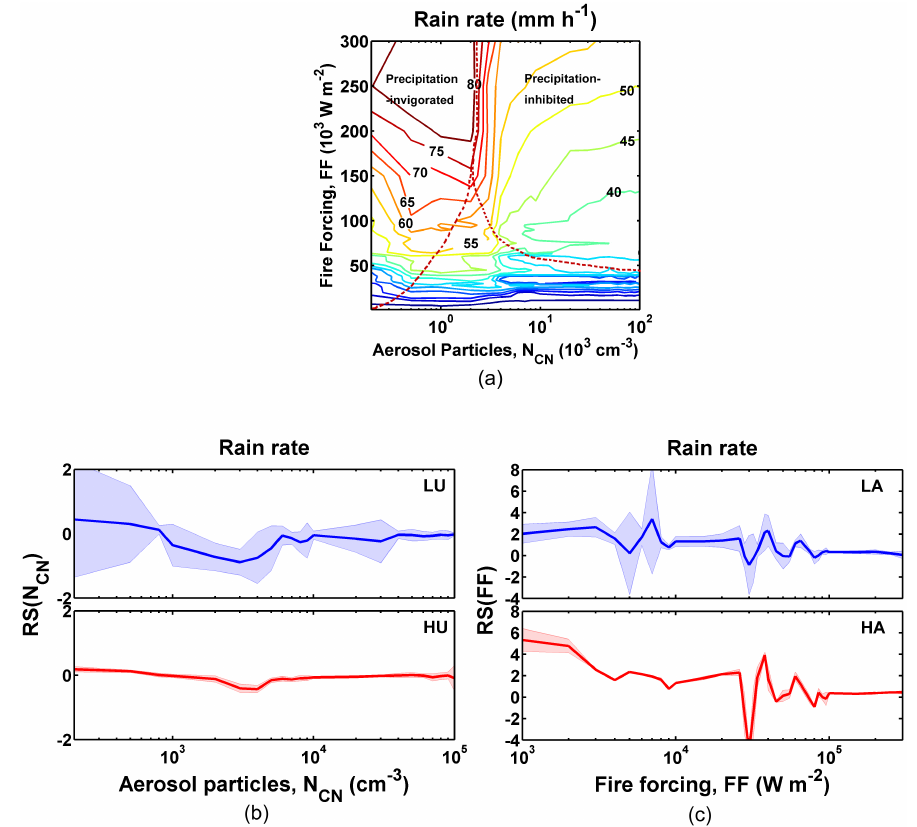
Figure 13. Same as Fig. 7 but for surface rain rate.